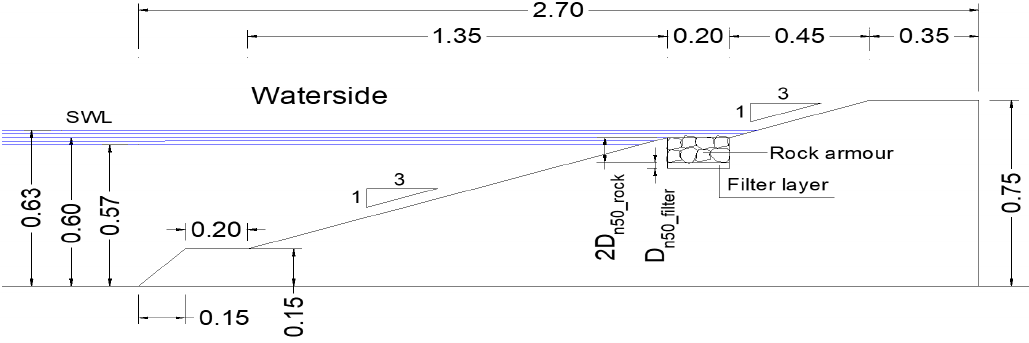
Figure 8. Test configuration (unit: m) of the RB tests, with a smooth upper slope, a rock-armoured berm and a smooth lower slope and with D n 50_ rock = 5 cm and D n 50_ filter = 2.5